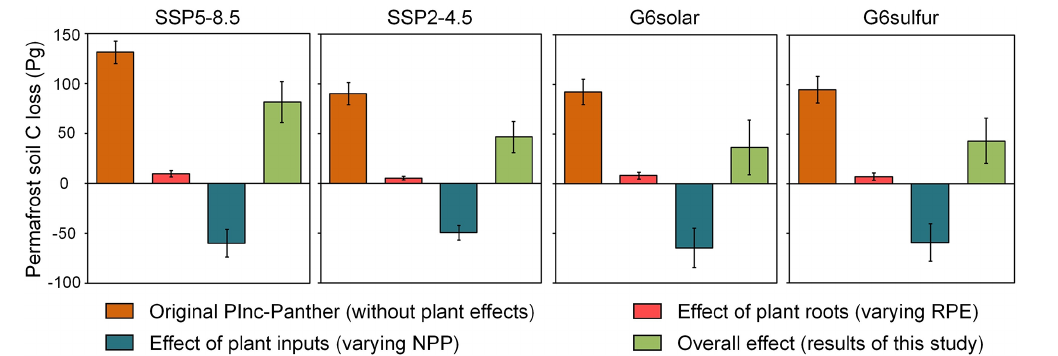
Figure 8. Cumulative permafrost soil C loss between 2020 and 2100 obtained from the original PInc-PanTher model (without plant effects) and the modified PInc-PanTher model we used (with varying NPP and RPE), as well as the effects of plant inputs (NPP) and roots (RPE) on soil C loss. Bars represent the ensemble mean of the six ESMs, with the error line range being the standard deviation. Negative values represent permafrost C